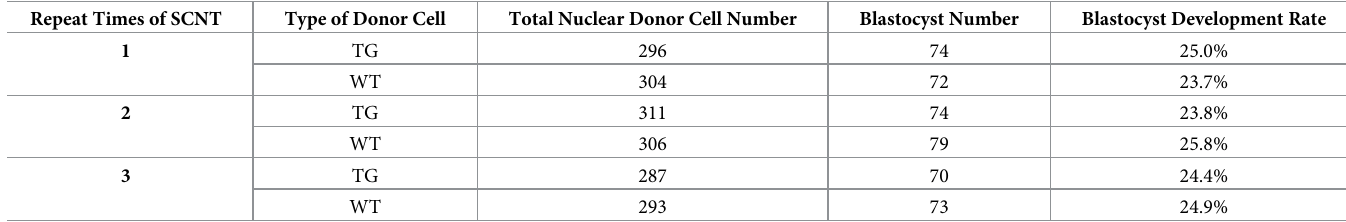
Table 2. Statistical results of the blastocyst development rate.